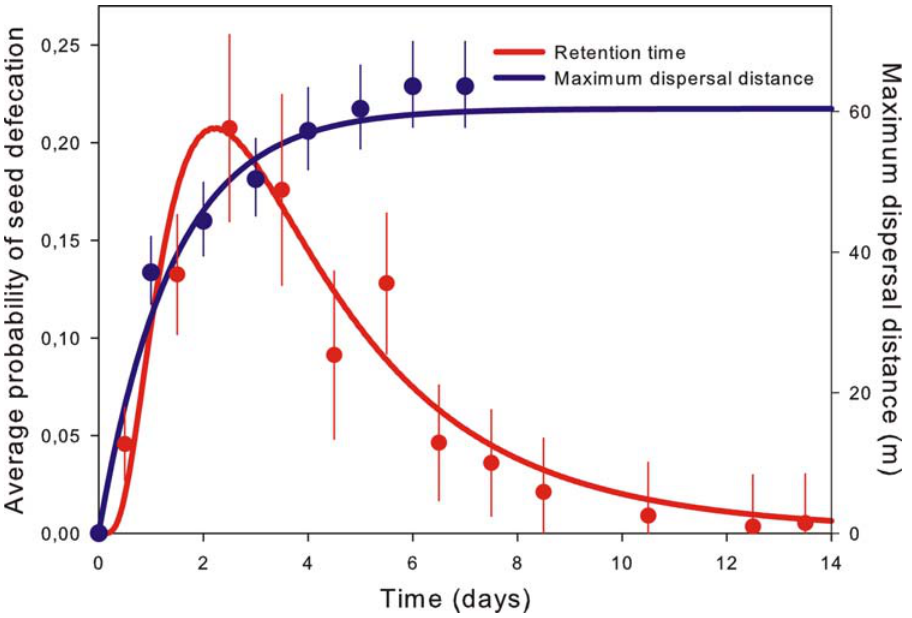
Figure 1. Two main determinants of seed dispersal by Balearic lizards: the retention time of seeds in the lizard’s gut (left axis) and lizard movement over time (right axis). Seed retention time shows the relative frequency of defecation of previously ingested seeds (curve derived from a cumulative log-normal fit). Maximum dispersal distance shows the distance between successive relocations of lizards by telemetry and the centre of the lizard’s displacement kernel (exponential fit). Seed retention time peaks at the same time (48–72 hours) at which maximum dispersal distance of lizards saturates. For both variables, mean values ( 6 s.e.) per day are also represented; however, note that the displayed curves were fitted across all measured values (not shown for